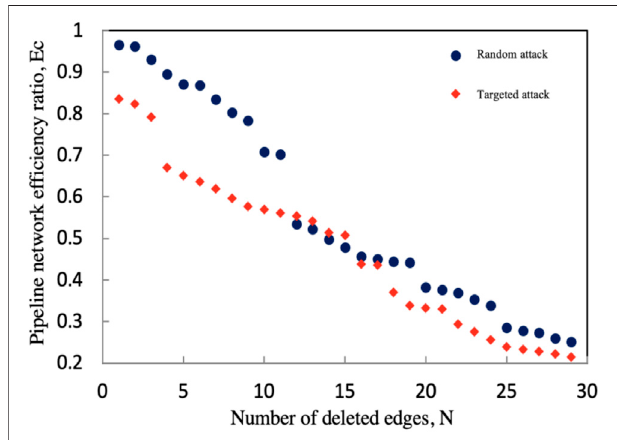
FIGURE 17 | The network robustness diagram under the random disturbance and the targeted